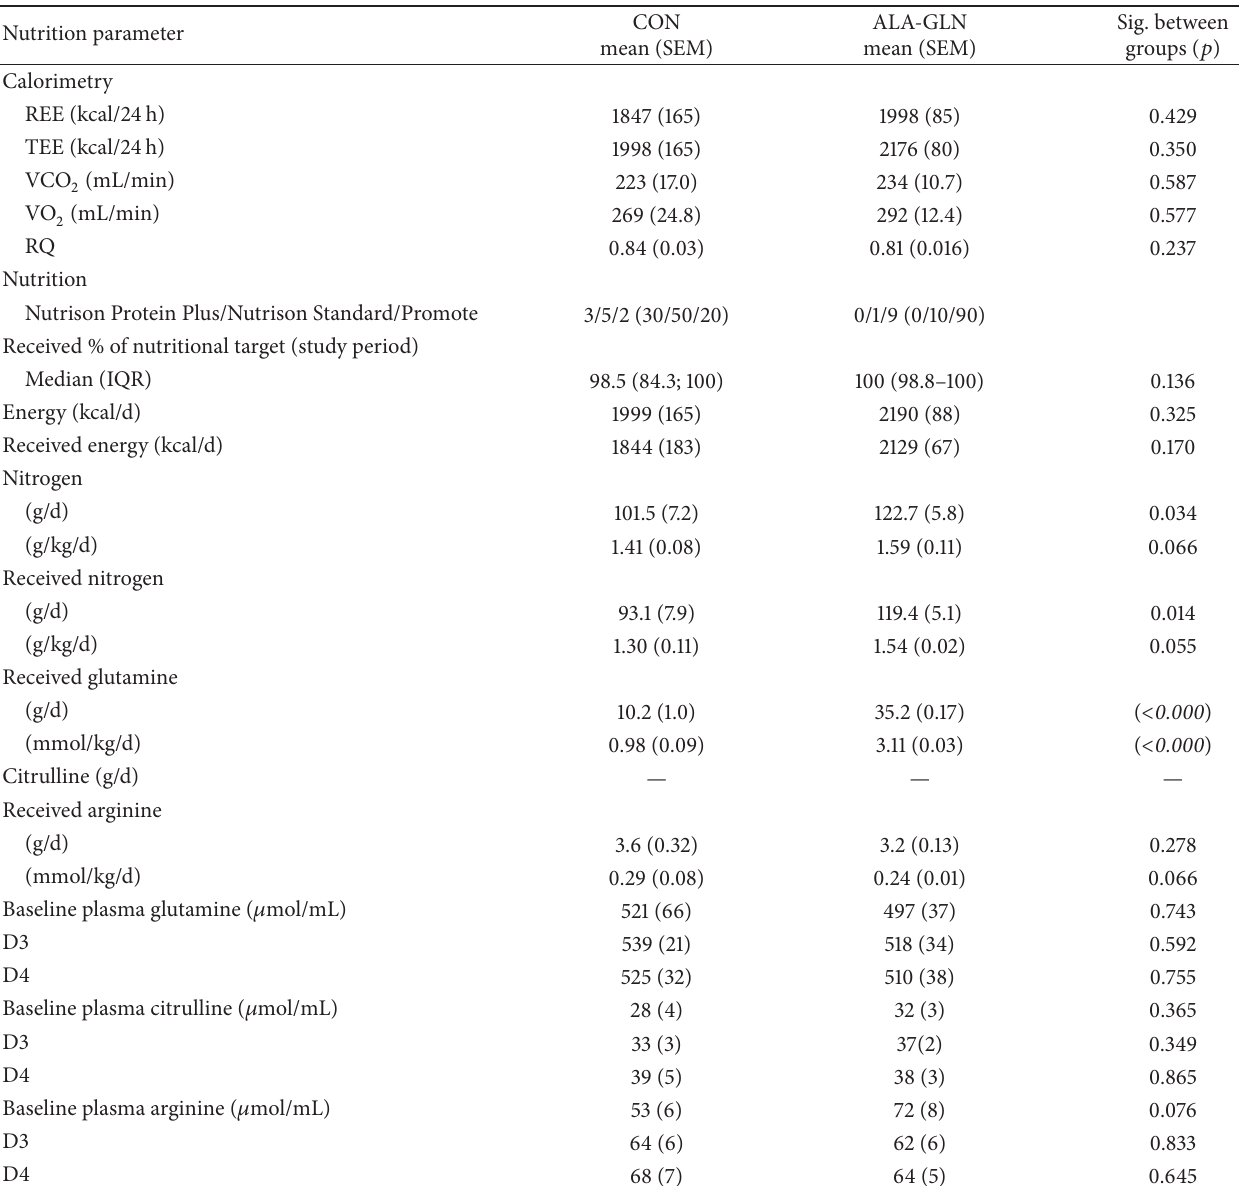
Table 4: Nutrition